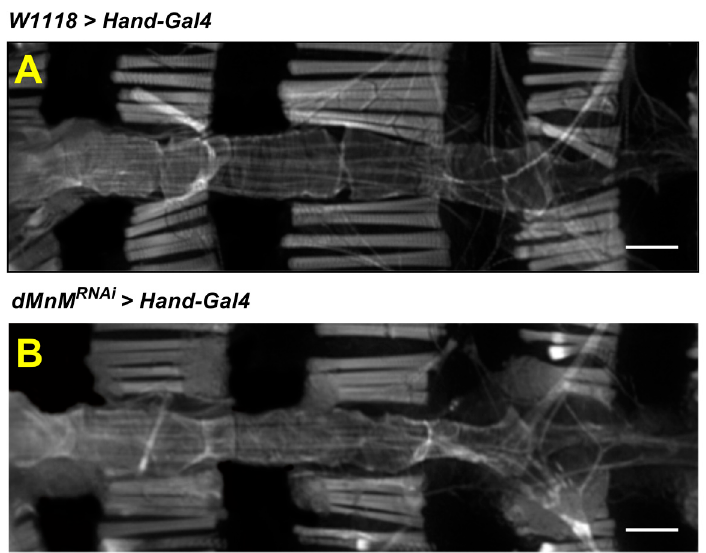
Figure 2. Effect of dMnM knockdown in cardiomyocytes on myofibrillar F-actin in cardiac myocytes. ( A ) Fluorescence images of the heart in the W1118 > Hand-Gal4 group; ( B ) fluorescence images of the heart in the dMnM RNAi > Hand-Gal4 group, n = 5. A confocal microscope was used to observe the Drosophila heart tube with ghost pen cyclic peptide-labeled F-actin, scale bar = 100 μ m.